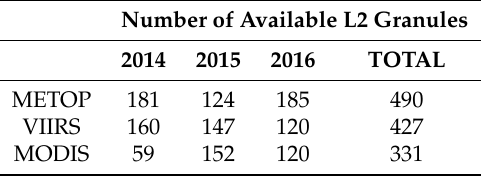
Table 1. Number of L2 granules available from 1 January 2014 to 31 December 2016 in the Northwest Australia case study